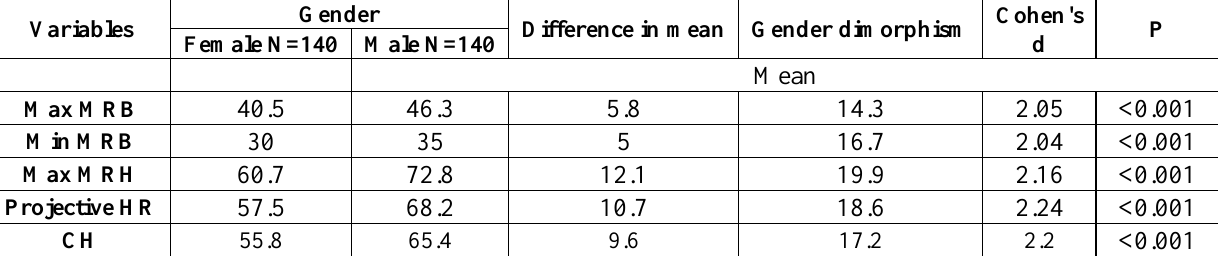
Table 2 : The gender differences in mean of unilateral linear mandibular ramus measurements Gender Variables Difference in mean